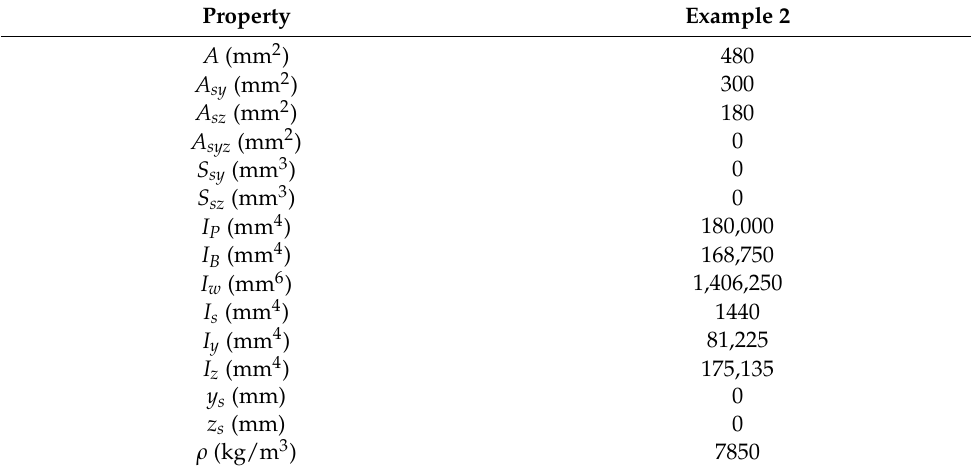
Table 5. Property details of example 2.